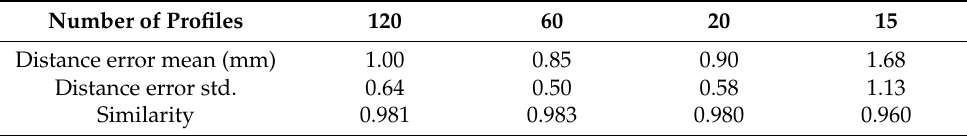
Table 4. Error evaluation for surface estimates of Model C.